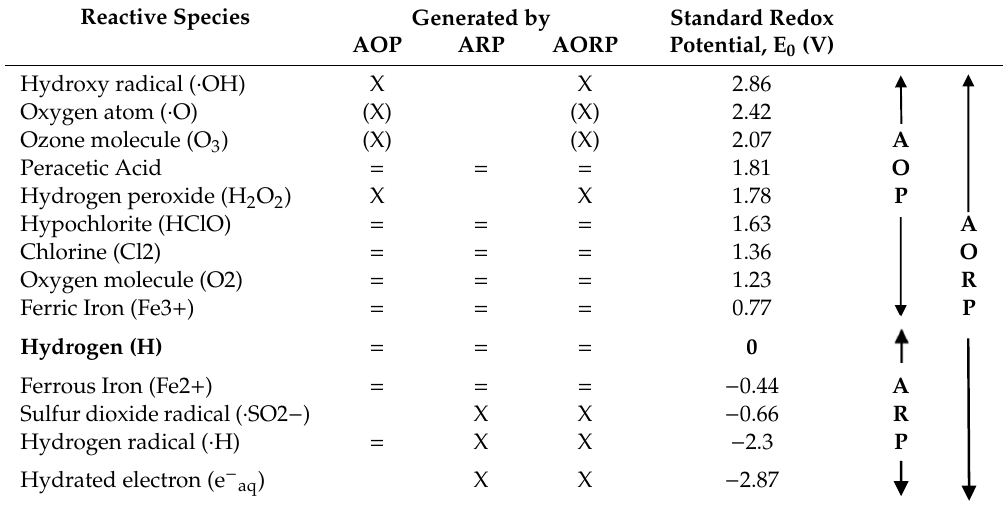
Table 4. Oxidation and reduction potential of different radical and commonly used reagents.